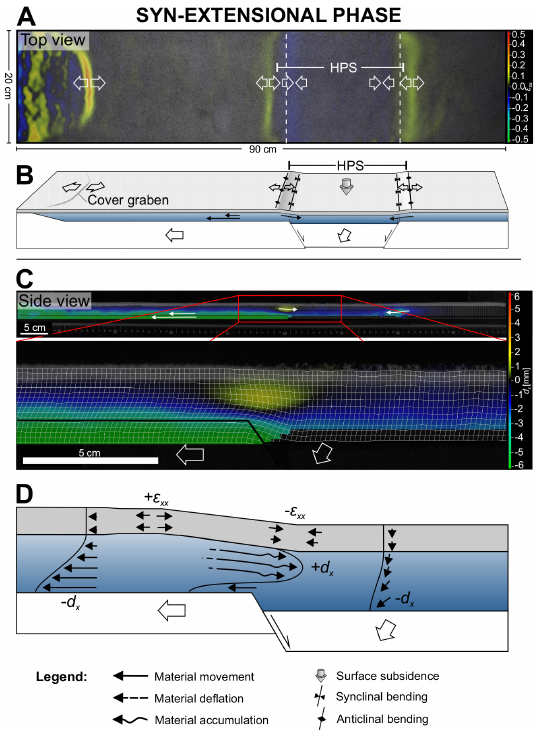
Figure 6. Results of PIV monitoring during syn-extensional phase of the reference experiments 1b and Exp. 1c. (a) Top view of Exp. 1c: lateral strain ε xx observed with PIV displaying zones of extension (yellow) and zones of compression (blue). Dashed lines indicate location of basal faults. HPS = hanging wall peripheral sink. (b) Sketch showing the interpretation of the PIV strain pat- terns. (c) Side view of Exp. 1b: horizontal displacement d x ob- served with PIV including a detailed view of the left basement fault. Coloured areas display rightward (yellow–red) and leftward (green–blue) movement of the analogue material. (d) Conceptual sketch (arrows are not to scale) summarizing the interpreted dis- placement patterns and showing vector profiles representing the ma- terial movement. The viscous material above the fault tip flows to- wards the hanging wall side opposed to the shearing along the base-